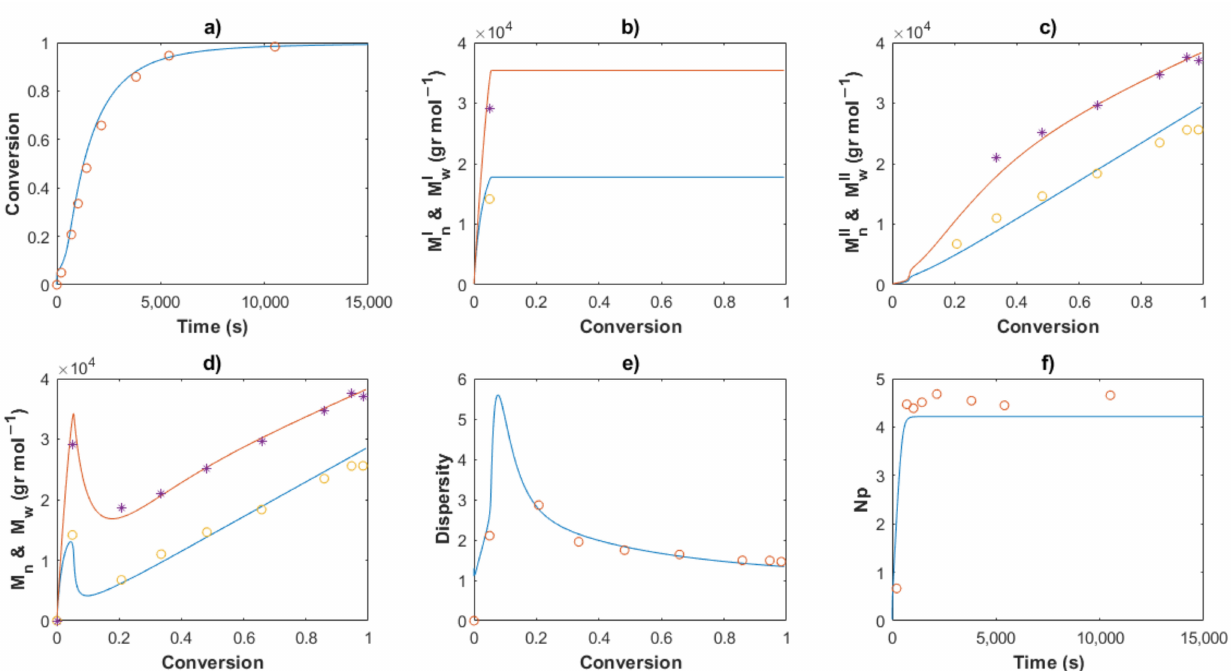
Figure 7. Comparison between the experimental data (symbols) and the model solutions (lines) for Exp 4: ( a ) Conversion profiles, ( b ) M nI and M wI versus conversion, ( c ) M nII and M wII versus conversion, ( d ) M n and M w versus conversion, ( e ) Dispersity, ( f ) Np versus time.